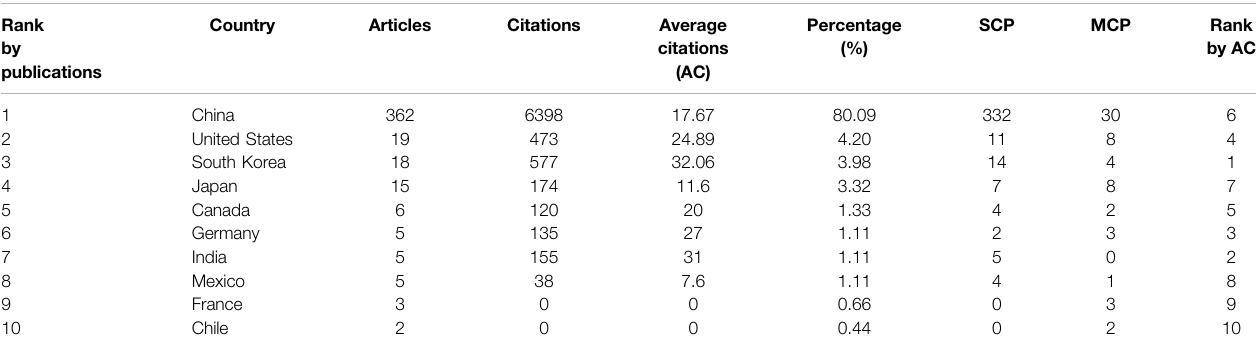
TABLE 4 | Top 10 Country distributed by publications and